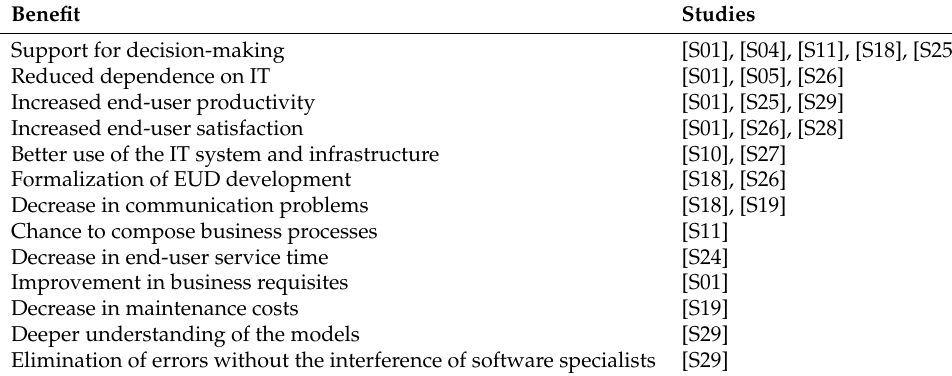
Table 3. SQ2—List of